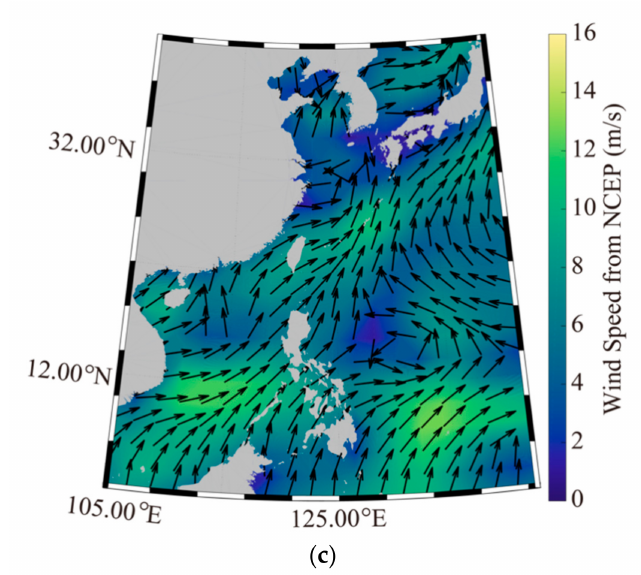
Figure 1. ( a ) The wind maps from the Cross Calibrated Multi-Platform (CCMP), ( b ) the European Centre for Medium-Range Weather Forecasts (ECMWF) , and ( c ) the National Centers for Environmental Prediction (NCEP) Global Forecast System (GFS) at 18:00 UTC on 1 July 2015.